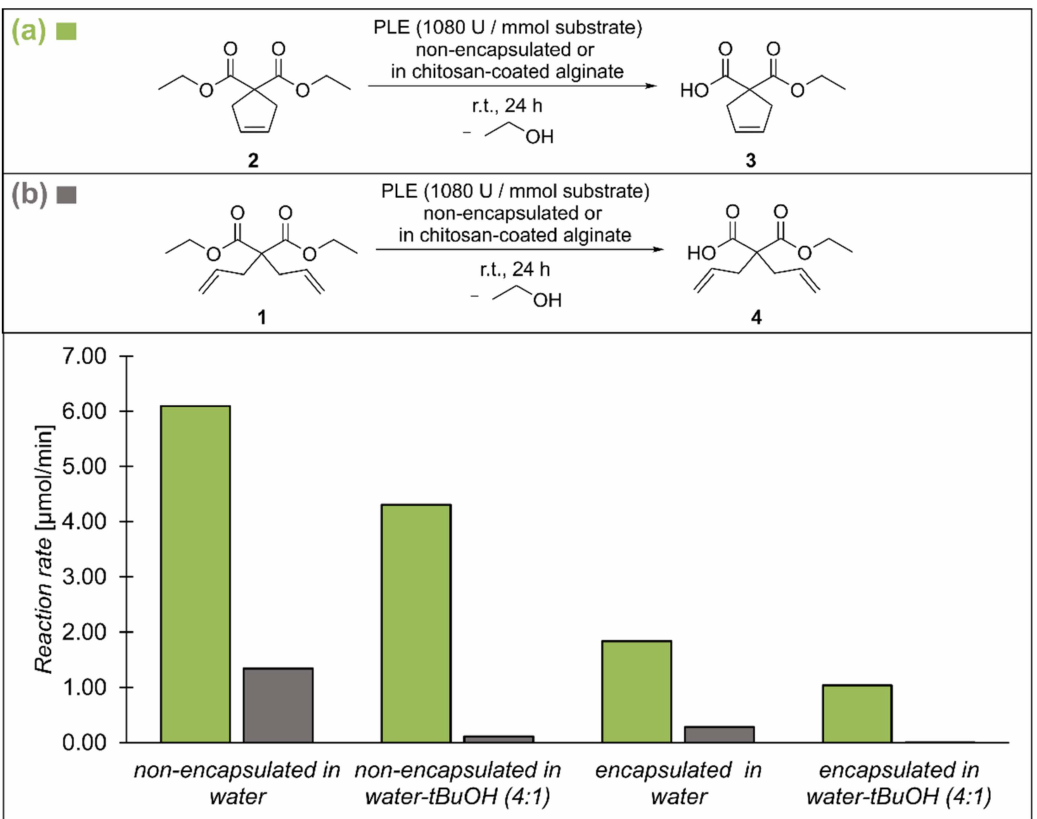
Figure 1. Benchmark enzymatic ester hydrolysis revealed higher reaction rates for desired reaction (( a ), green) than for side reaction (( b ), grey) in di ff erent reaction